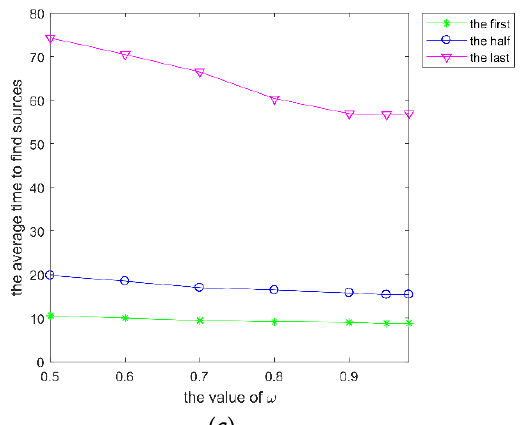
Figure 3. mI of SRPB at different w , which varies within (0.5,0.98). ( a ) the average number of located sources; ( b ) collision rate; ( c ) average time to find different sources.